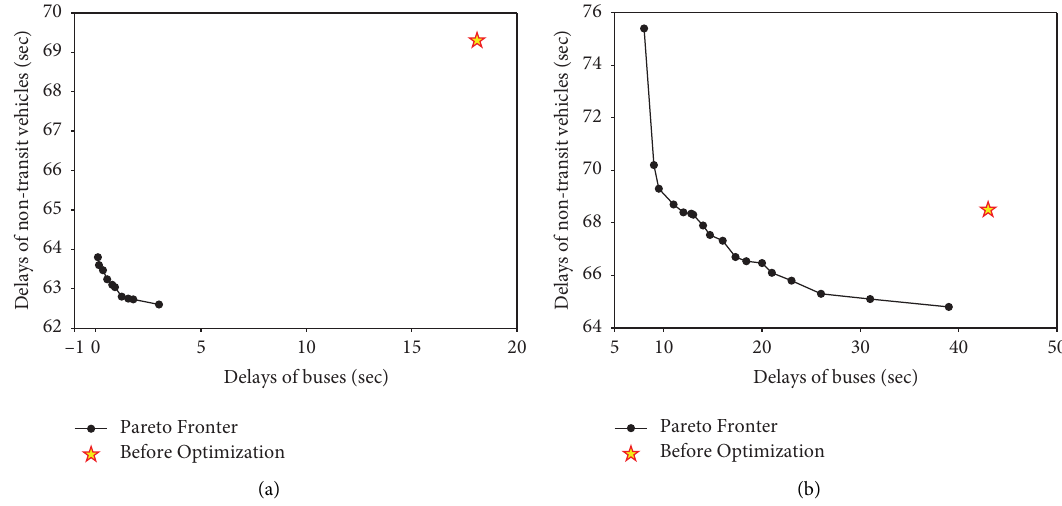
Figure 11: Pareto frontier of two typical cases. (a) Diferences of efect are small. (b) Diferences of efect are